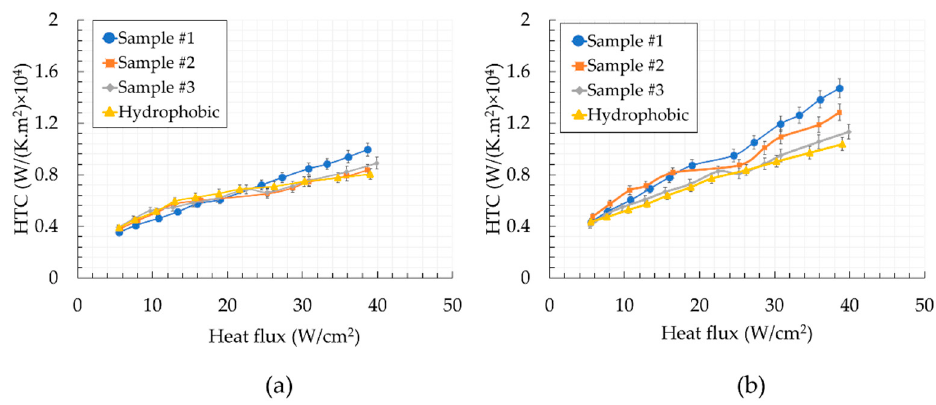
Figure 5. Obtained heat transfer coefficients for mass flux of 40 kg m − 2 s − 1 ( a ) for the 1st half of the microchannel ( b ) for the 2nd half of the microchannel.